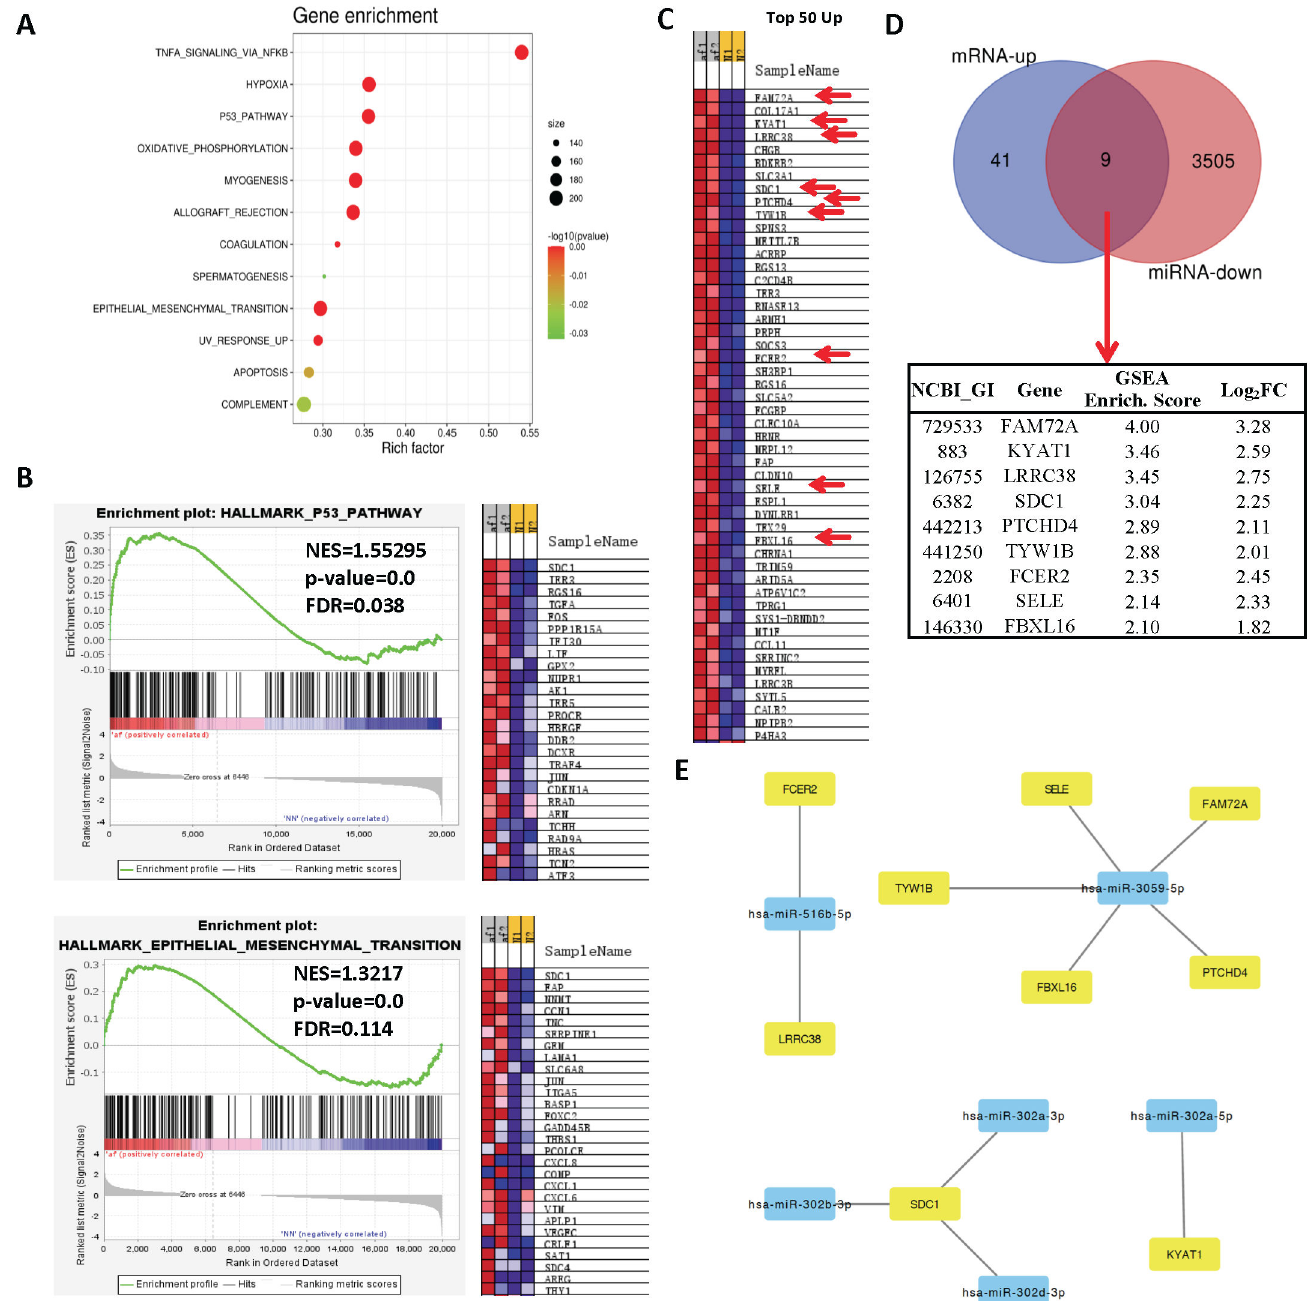
Figure 4. Analysis of upregulated genes and selection of candidate miR–mRNA pairs. ( A ) Gene-set enrichment analysis (GSEA) of upregulated genes. ( B ) Enrichment plots of some of the top enriched pathways. ( C ) Heat map showing top 50 positively enriched genes in GSEA based on enrichment score. ( D ) Venn diagram showing overlapping genes between top 50 positively enriched genes in GSEA (blue) and all predicted targets of top 11 downregulated miRs in RNA-seq (red). A total of 9 overlapping genes between groups were selected as potential candidates and their enrichment scores and log 2 (FoldChanges) are listed in the table. ( E ) Interaction network of positively enriched genes in GSEA and their negatively correlated